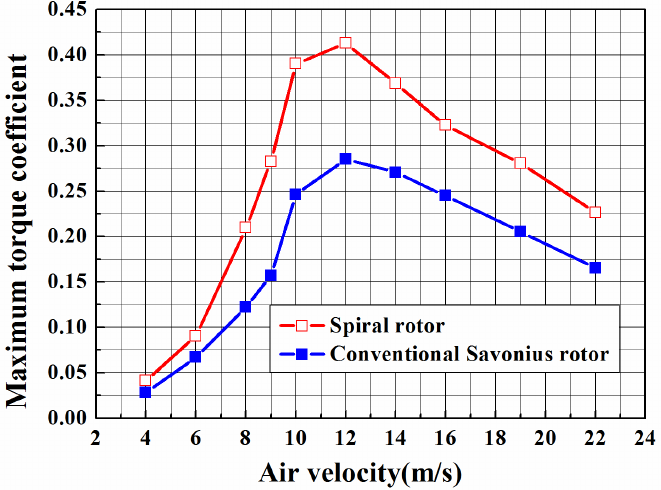
Figure 3. Variation of maximum torque coefficient with air